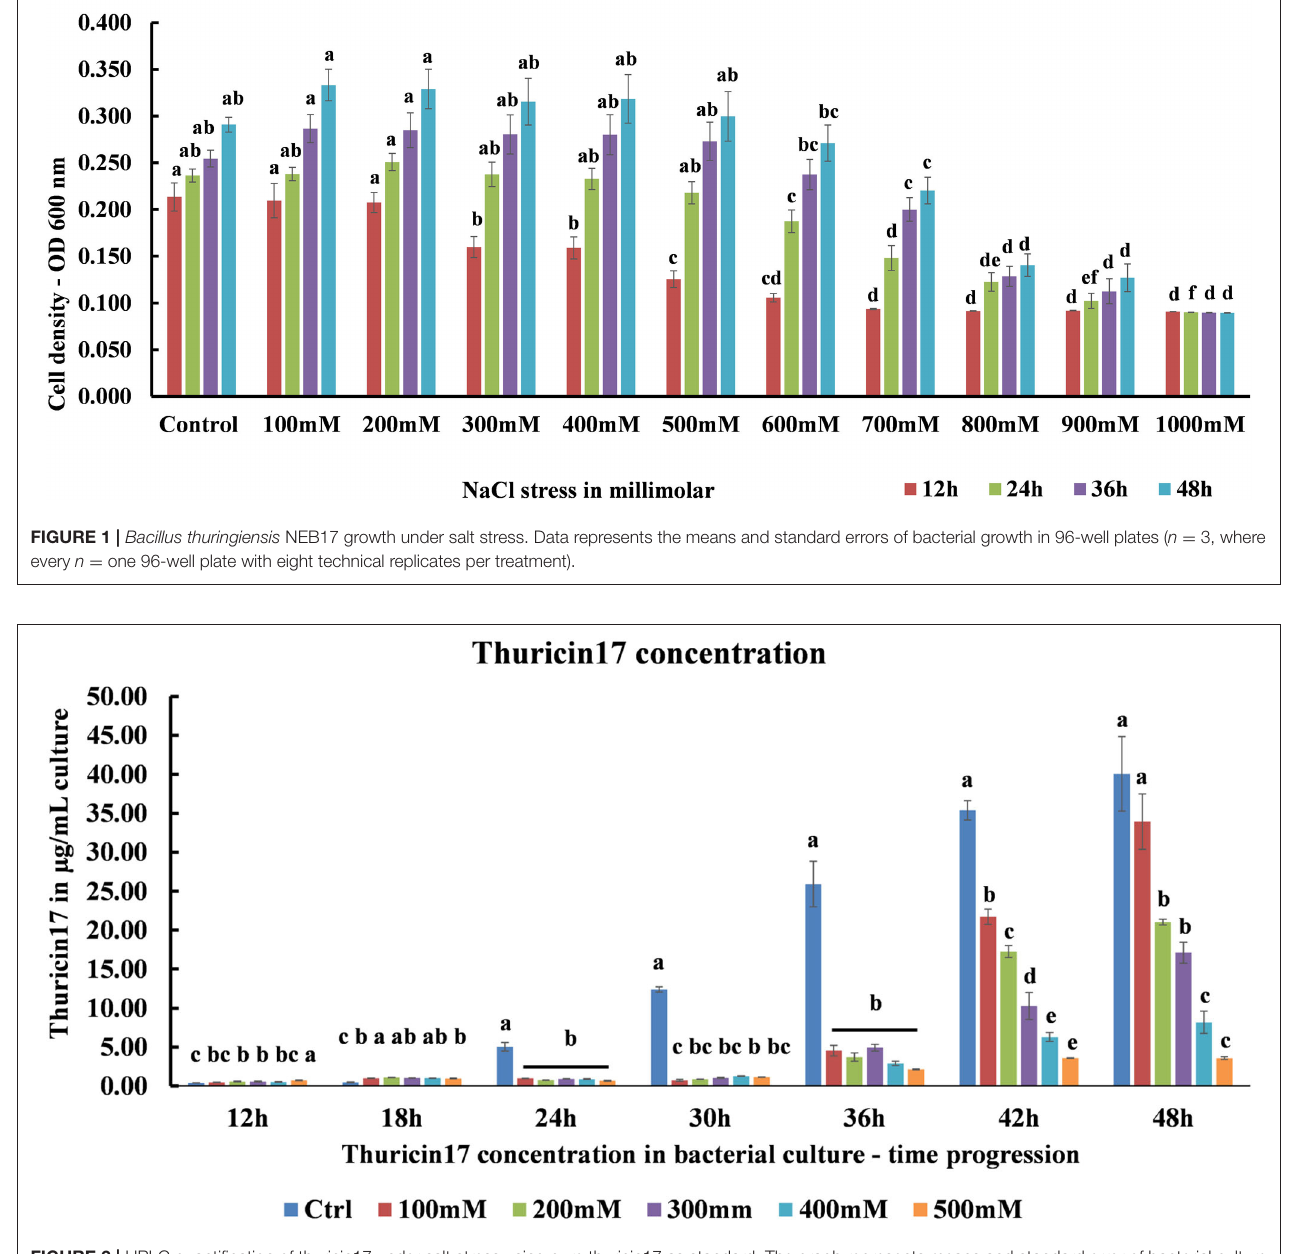
Frontiers in Sustainable Food Systems | www.frontiersin.org